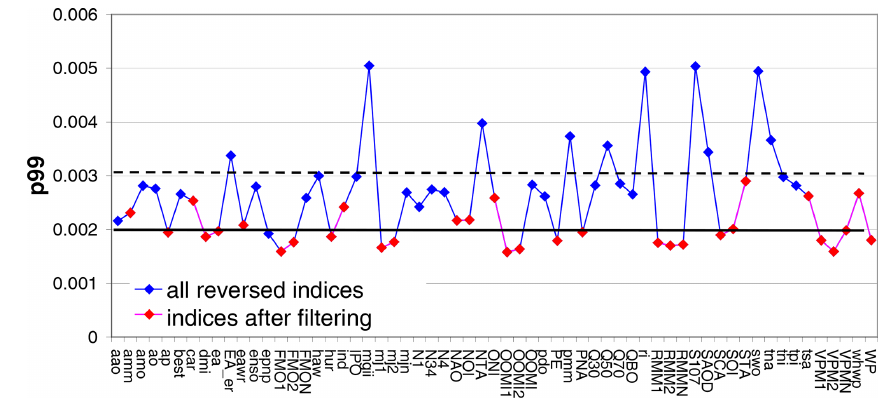
Figure A4. The 99th percentiles (p99) of the delta rms of the temporally reversed indices for the TCWV from satellite observations (same as in Fig. 7, top). The blue markers indicate indices which are excluded from the calculation of the significance threshold (for details see text).